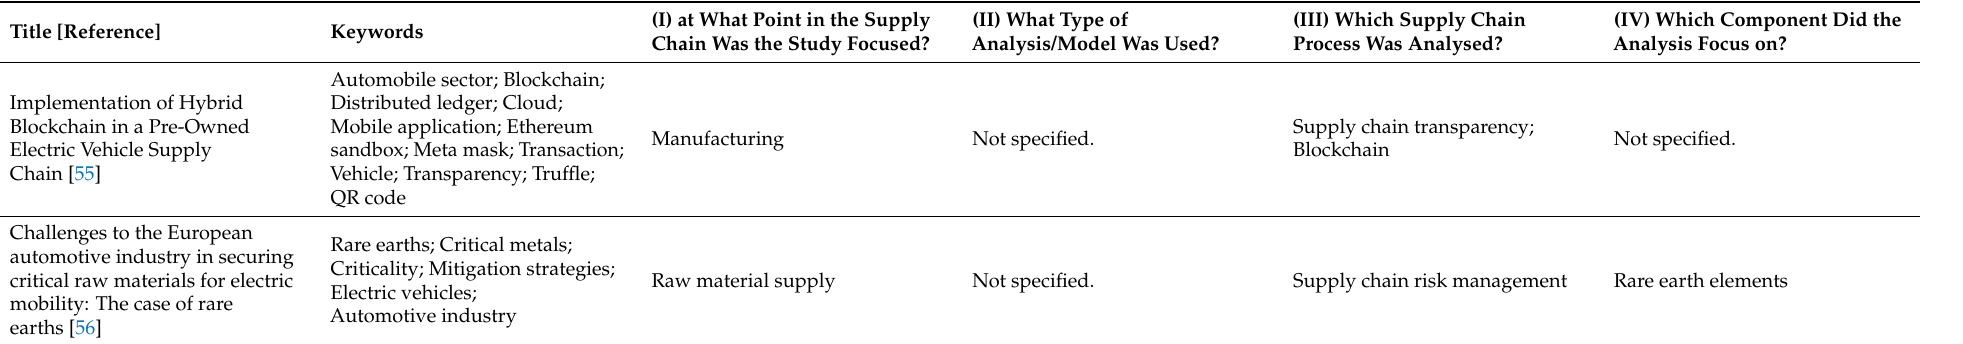
Table A6. PRISMA meta-analysis of documents found related to electric vehicles supply chains.